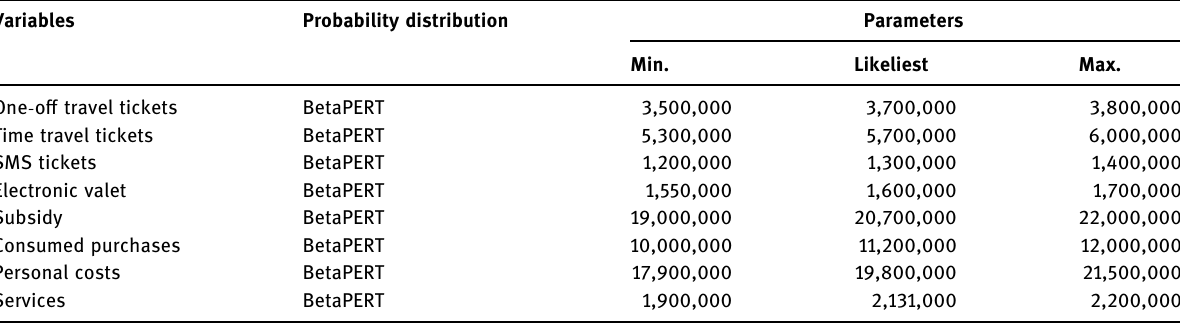
Table 2: Probability distributions and statistical parameters in EUR